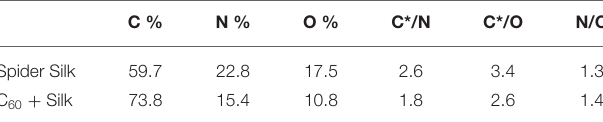
TABLE 1 | Atomic percentage of all the chemical species present in the